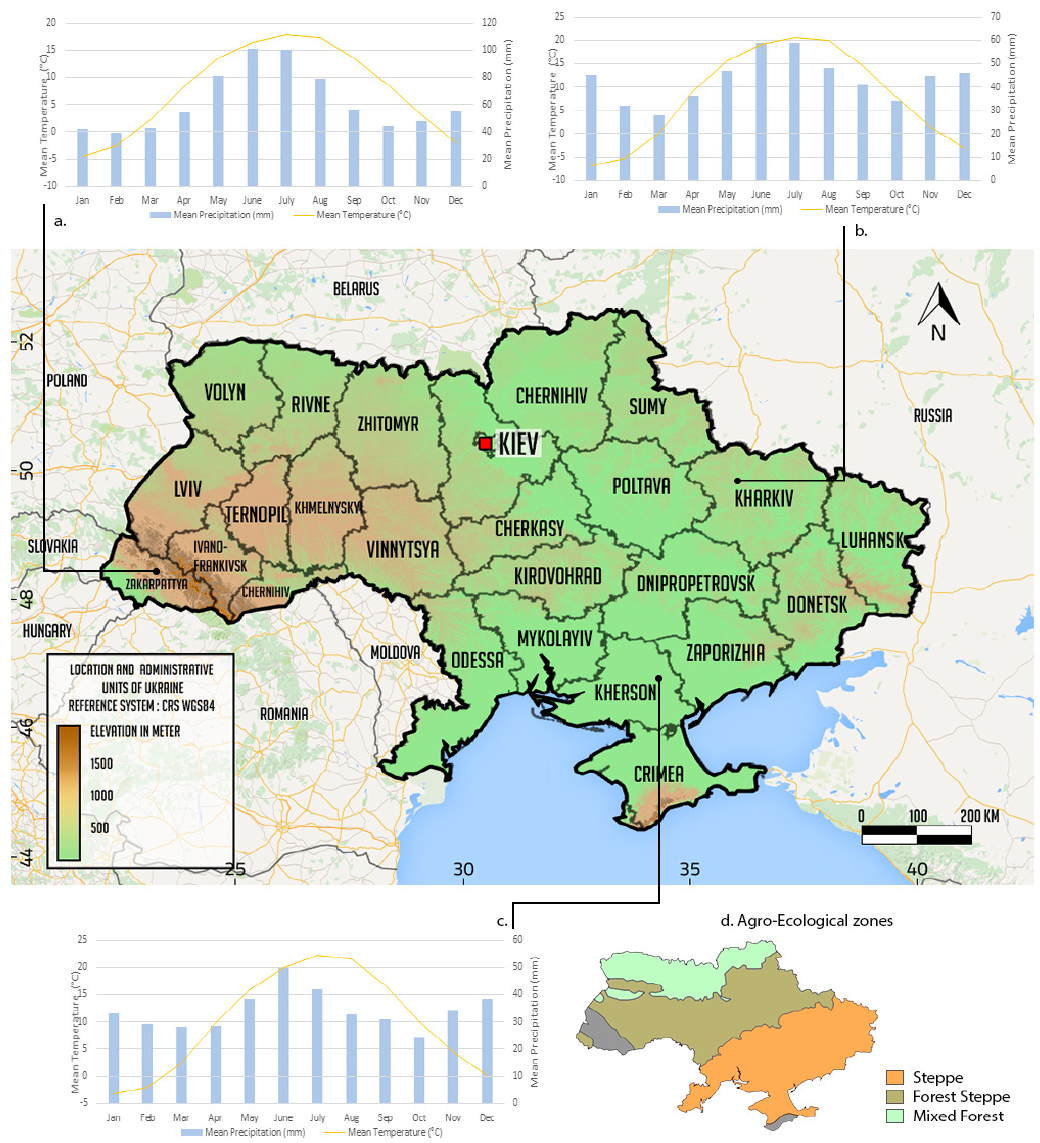
Figure 1. Study area, the Walter-Lieth climate graphs for different locations in the country ( a – c ) and the agro-ecological zones ( d ) [26].